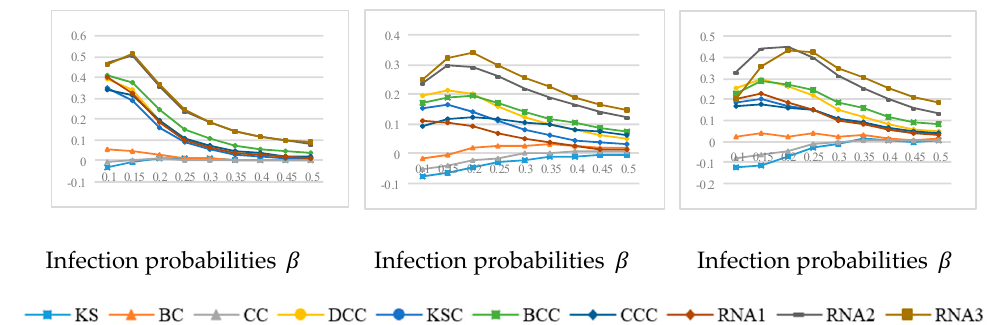
Figure 4. In the single-point contact SIR model, the relationship between ∆ and β with 5% nodes in the key node set.